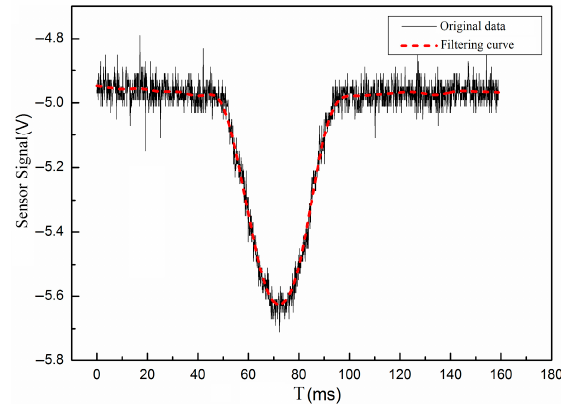
Figure 2. Test curves after smoothing filtering.